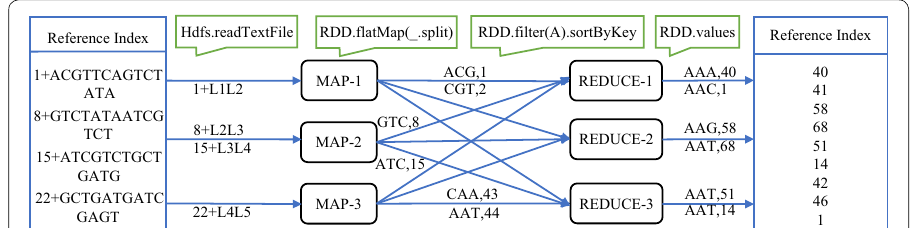
Fig. 4 Mapreduce architecture for Phase II (suffix index